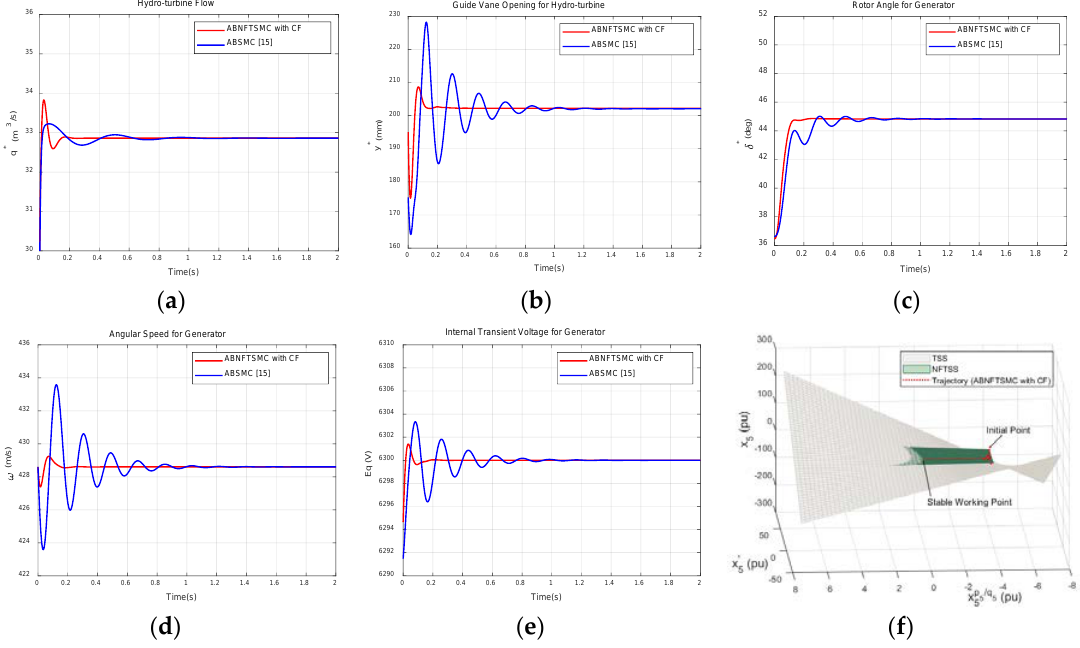
Figure 7. Responses in the scenario of stochastic intensity D = 0.6 of water flow. ( a ) the hydro-turbine flow; ( b ) the guide vane opening for hydro-turbine; ( c ) the power angle for generator; ( d ) the angular speed for generator; ( e ) the internal transient voltage for generator; ( f ) phase trajectory of Subsystem 5 for NFTSS and TSS.